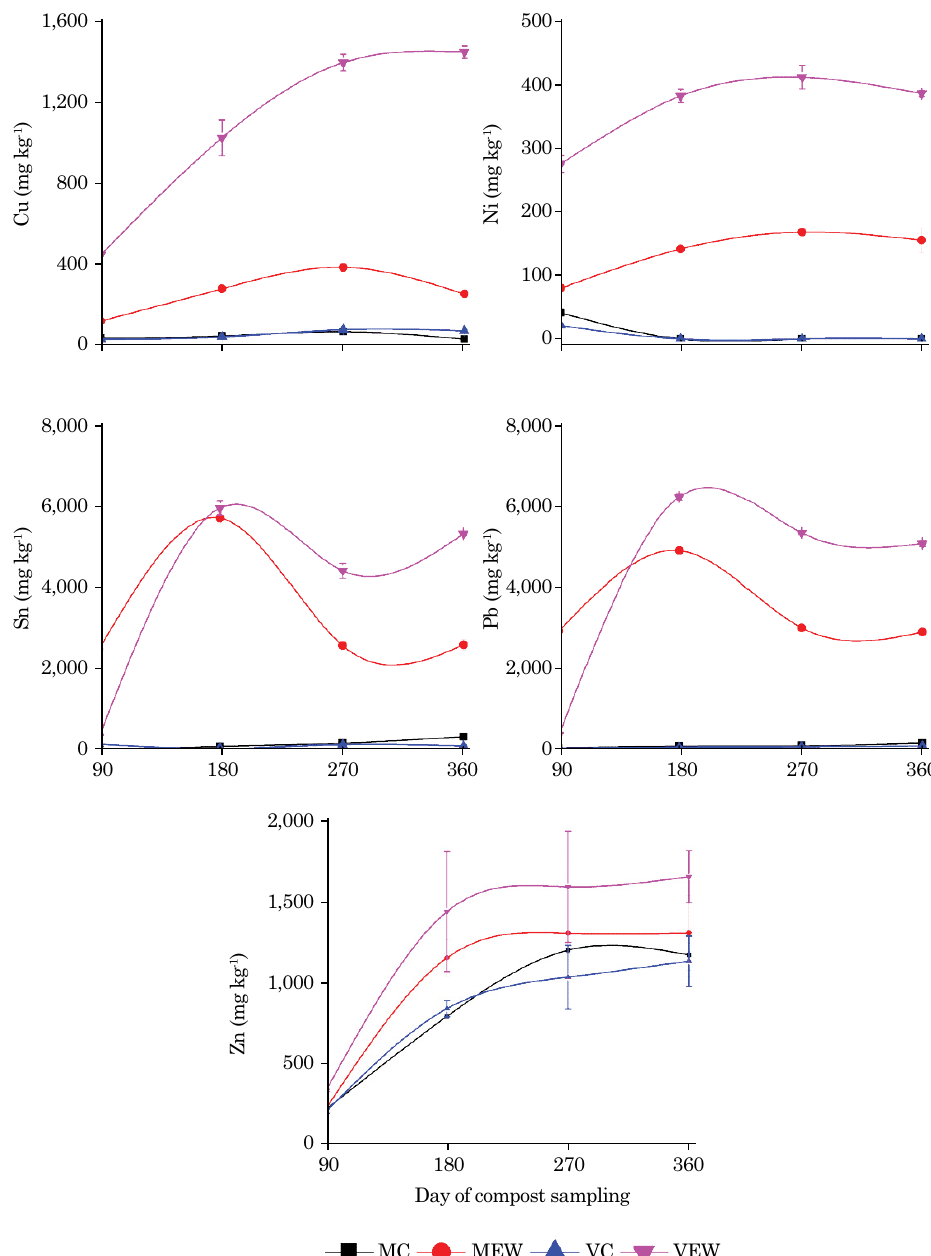
figure 3. total metal content (Cu, ni, Pb, sn, and Zn) in the compost